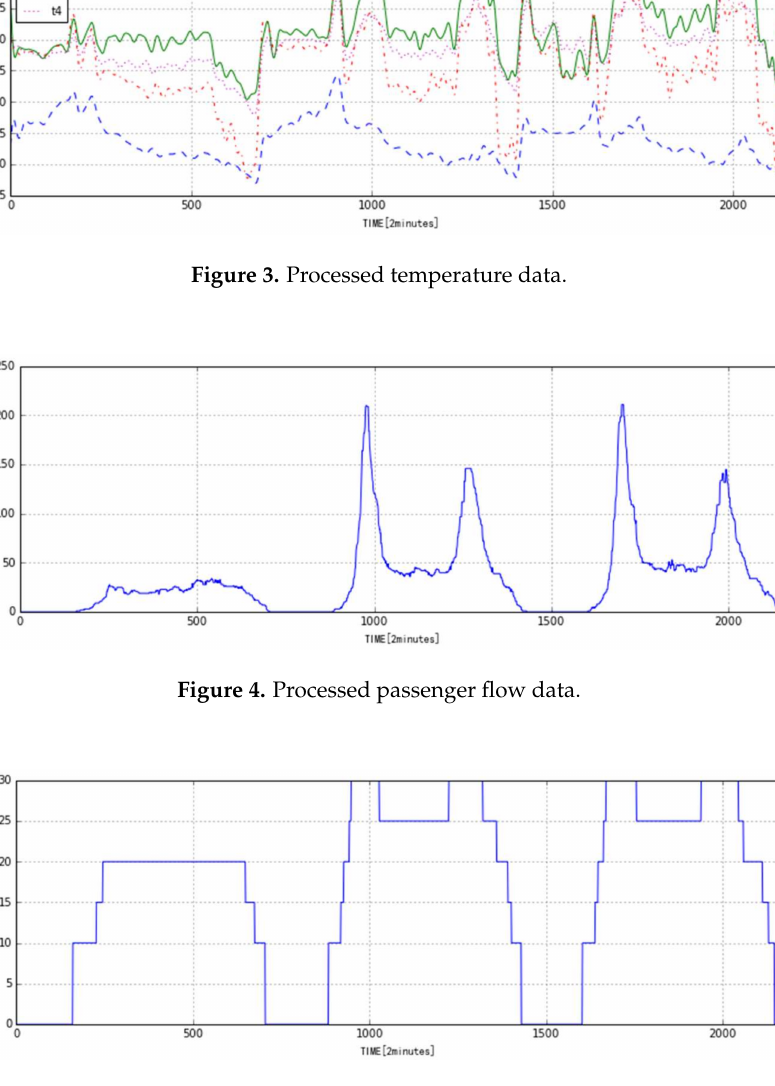
Figure 5. Metro train arrival